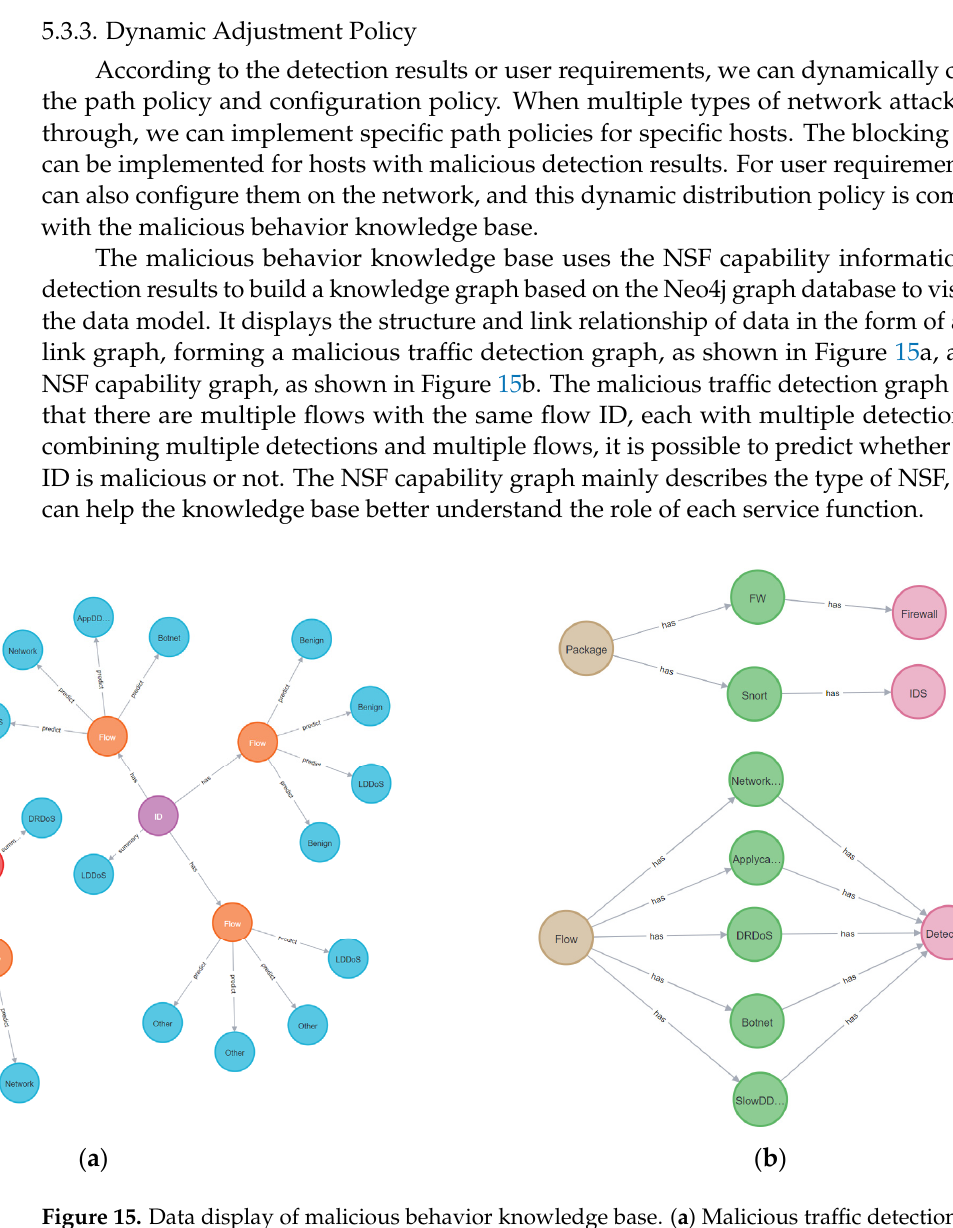
( b ) Figure 16. Advanced policy for blocking traffic. ( a ) Policy name and event. ( b ) Condition, actions and custom rules. Further path policy refinement can also be performed according to the characteristics of the service function. For example, for a certain IP address, only one detection module can be used to shorten the service time. The path policy is shown in Figure 17. The policy indicates that the traffic under the UDP whose source IP address is 10.10.13.3 and source port number is 245 will only pass the DRDoS Detection module to complete the detection. For the AppDDoS service function and the LDDoS service function, compared with other service functions, these two types of functions focus more on detecting HTTP traffic. HTTP packets use port number 80. Therefore, to detect DDoS attacks related to the HTTP, packets with port number 80 can be detected using only these two service functions.